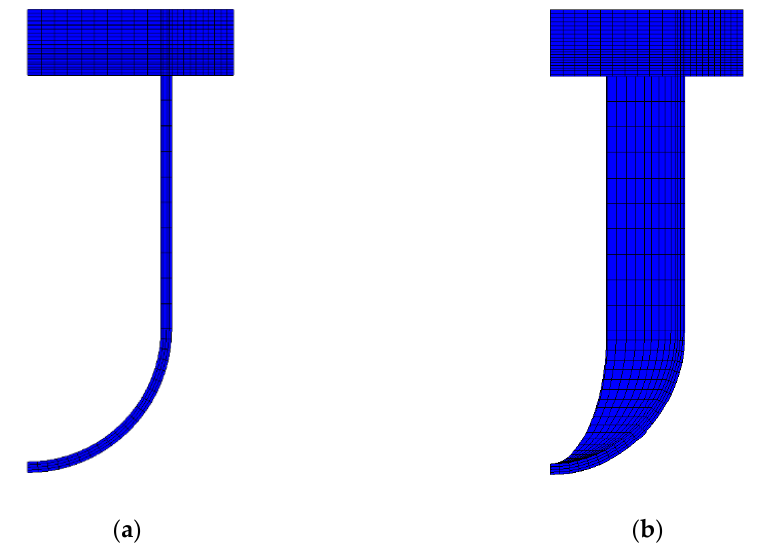
Figure 9. FOREVER vessel rig geometry (units are in mm) [6].